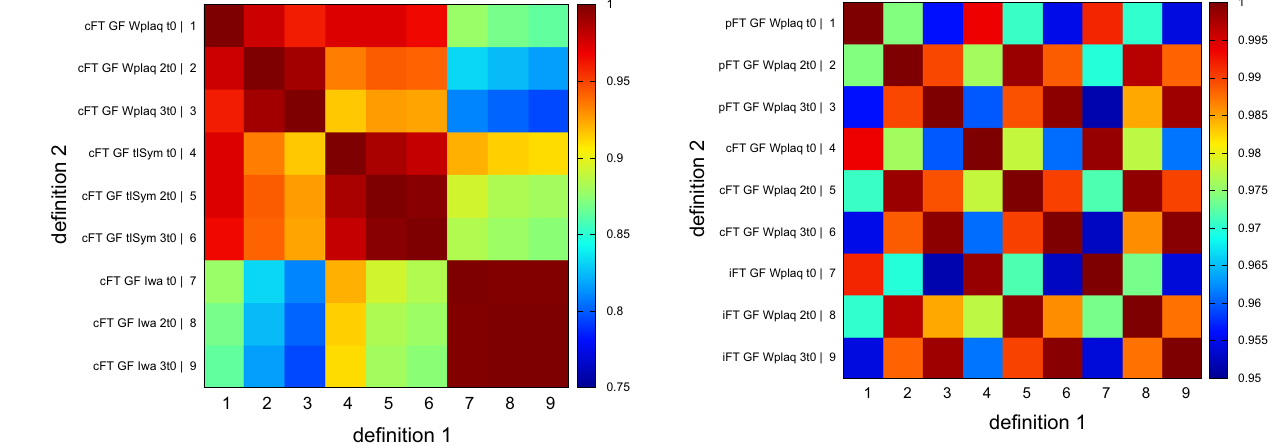
cient between different definitions and its error (0 means that the error is smaller than